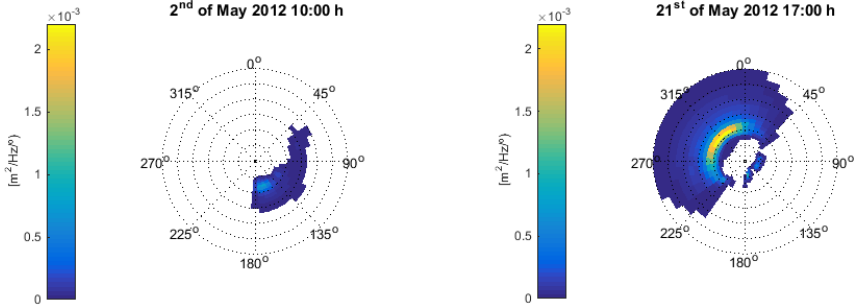
Figure 7. Numerical wave spectra for two different instants at the observational point: without wind jet event (left panel: 2 March 2012) and during wind jet event (right panel: 21 March 2012).